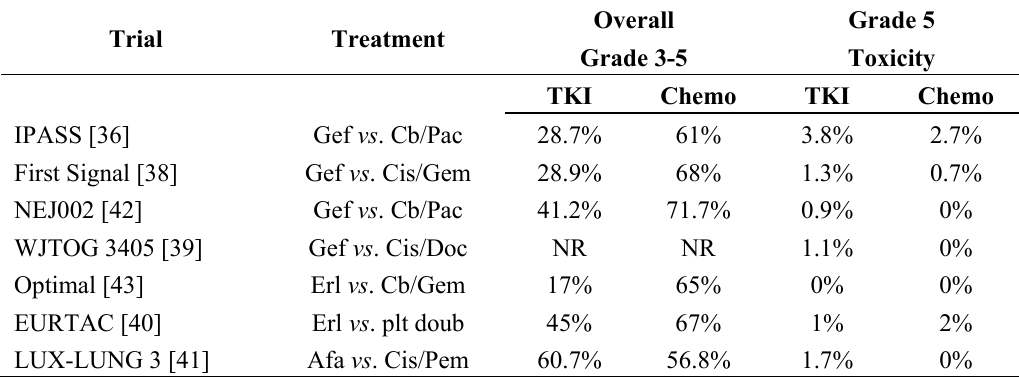
Table 2. Summary of toxicity in first-line trials of EGFR